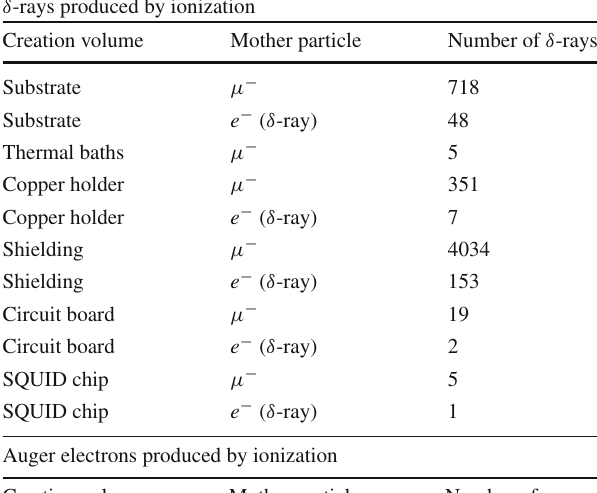
Table 2 Number of created particles in a simulation of 1 . 8 × 10 6 pri- mary muons. Only particles which or whose daughter deposit energy in the absorbers are listed δ -rays produced by ionization